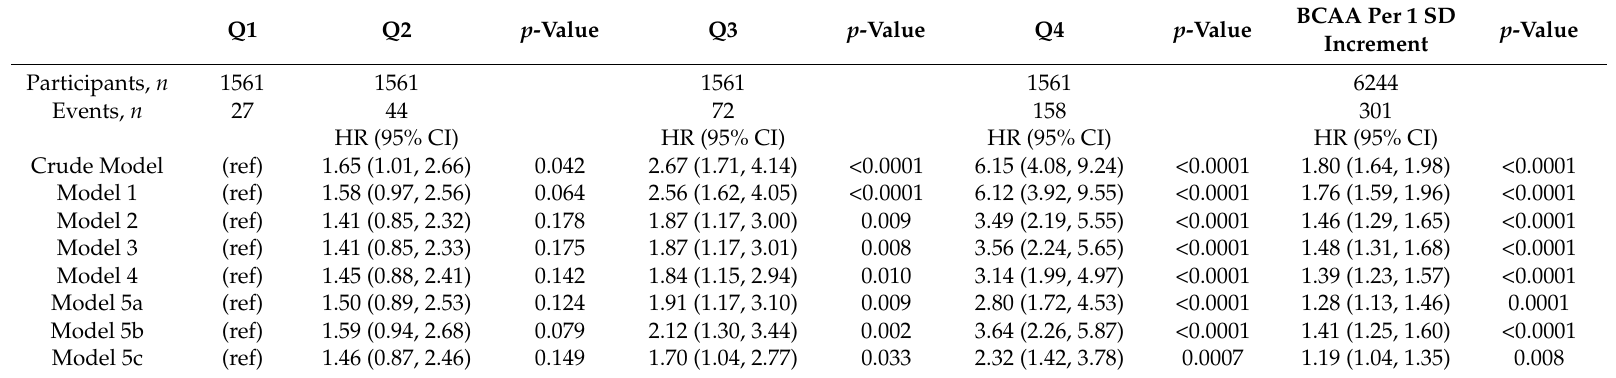
Table 4. Prospective associations of BCAA with risk of Type 2